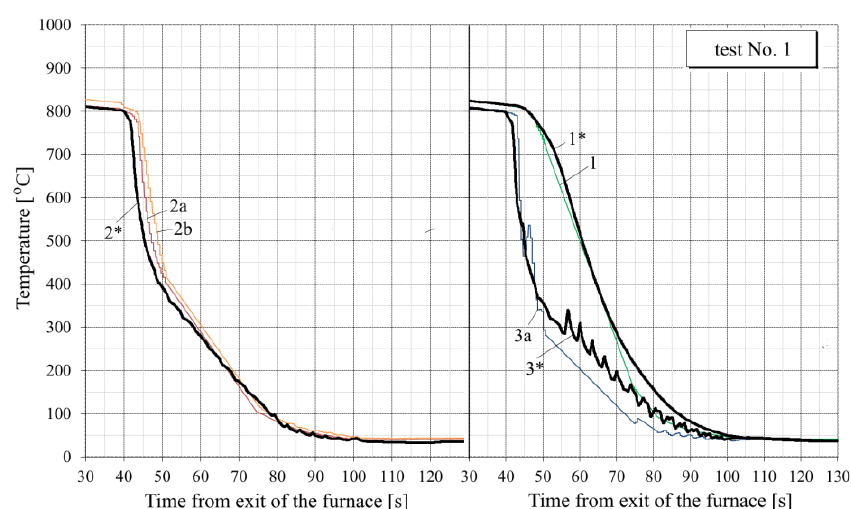
Figure A1. Graphs of cooling in test No. 1. Numbers without an asterisk denote experimental curves according to the thermocouple data: 1 — at the center of the thickness in the middle of the plate width; 2a — at the top in the middle of the width; 2b — at the top at the edge; 3a — at the bottom in the middle of the width. Numbers with one asterisk indicate calculated curves for the corresponding control points across the thickness of the plate: 1* — at the center of the sheet thickness; 2* — at a depth of 3 mm from the top surface; 3* — at a depth of 2.5 mm from the bottom surface.